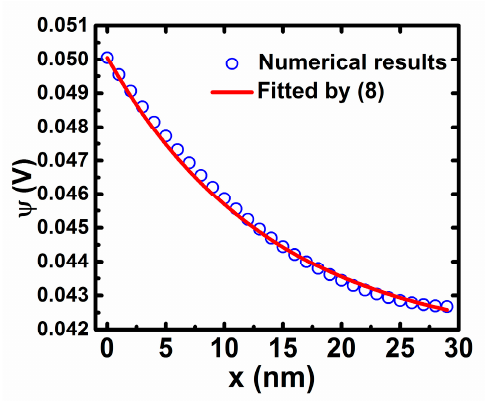
Figure A1. The potential distribution by numerical solution for (A5).